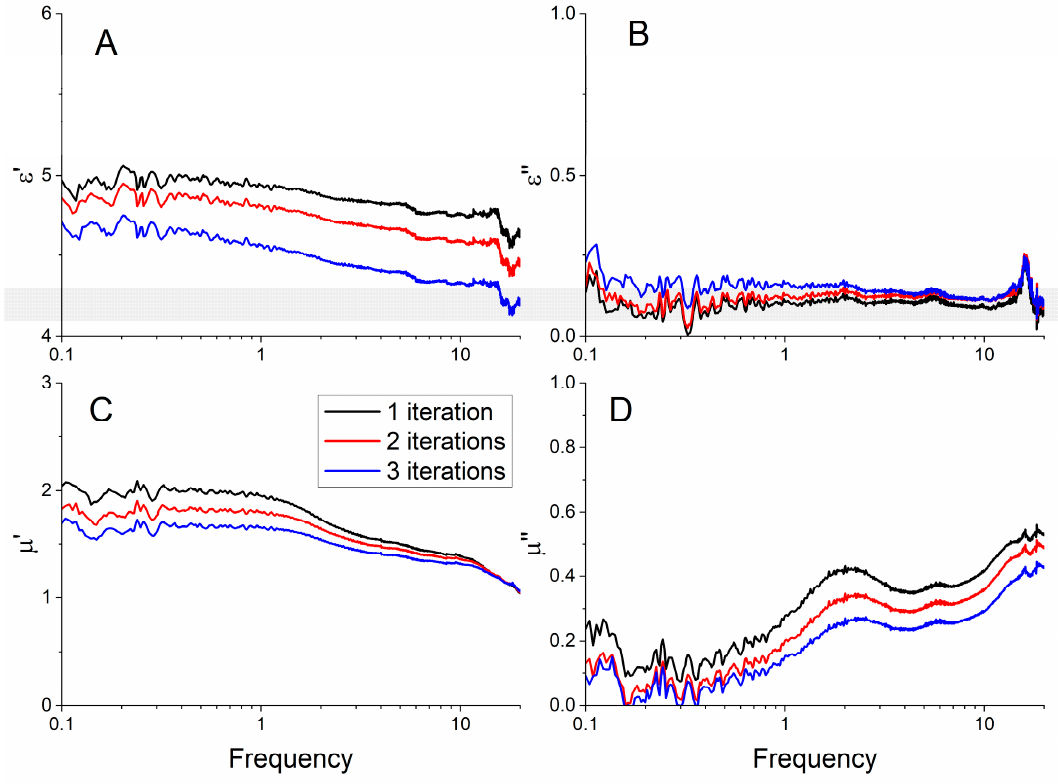
Figure 12. Frequency dispersion of permittivity ( A , B ) and permeability ( C , D ) in the experiments with a different number of iterations of the SiO 2 shell deposition.